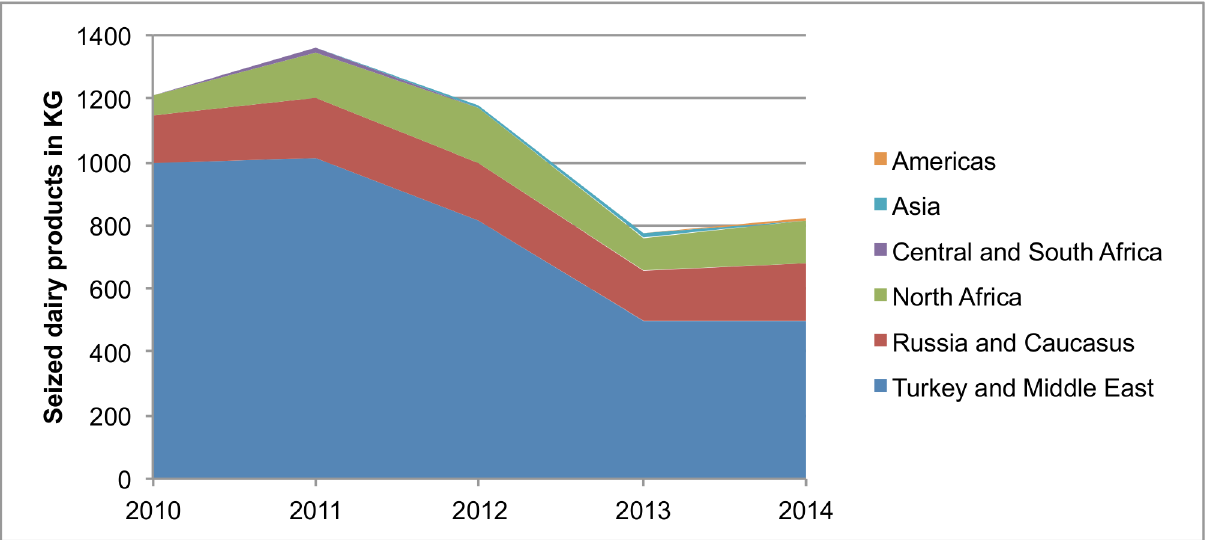
Fig 4. Seized dairy products (in kg) at IA 1 according to region of origin, 2010 –